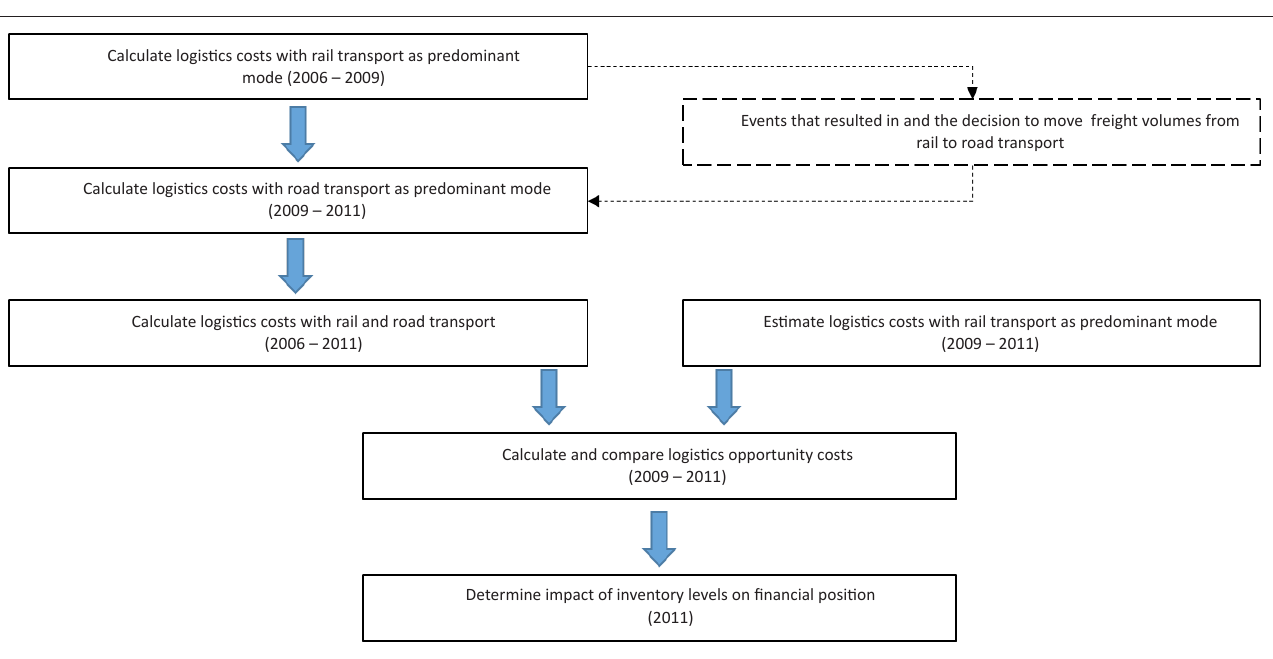
FIGURE 4: Framework for determining Firm A’s logistics opportunity